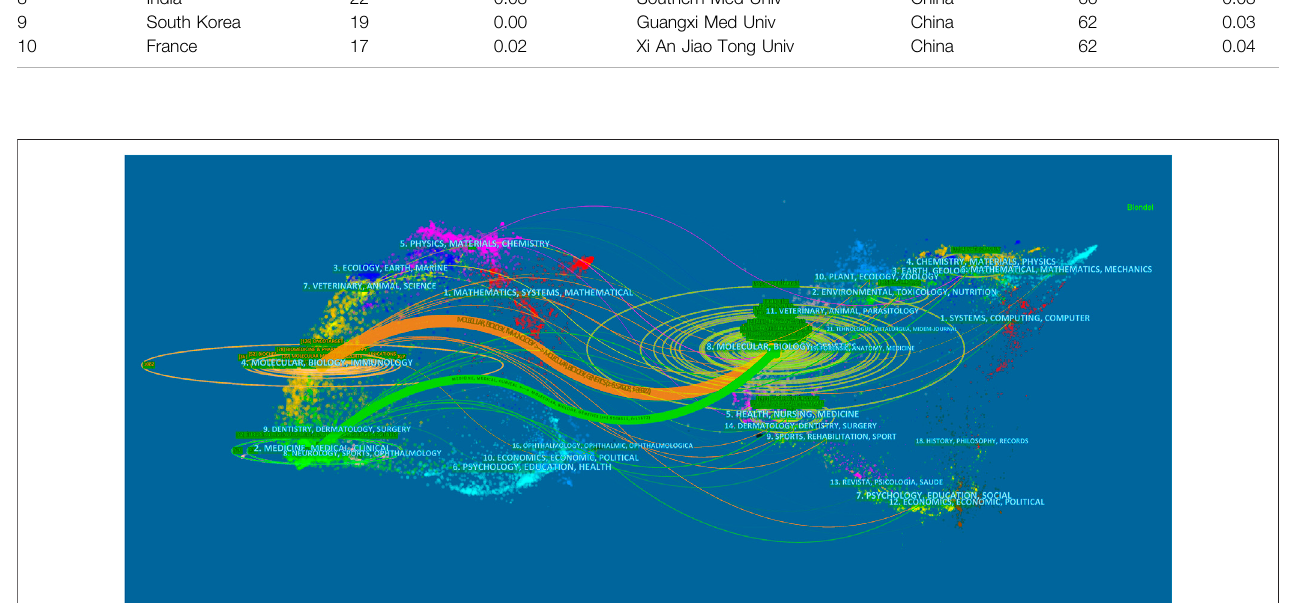
FIGURE3| Thedual-mapoverlayofjournalsrelatedtolncRNAinHCCresearch.Notes:Thecitingjournalsareontheleft,thecitedjournalsareontheright,andthe colored path represents citation relationship.